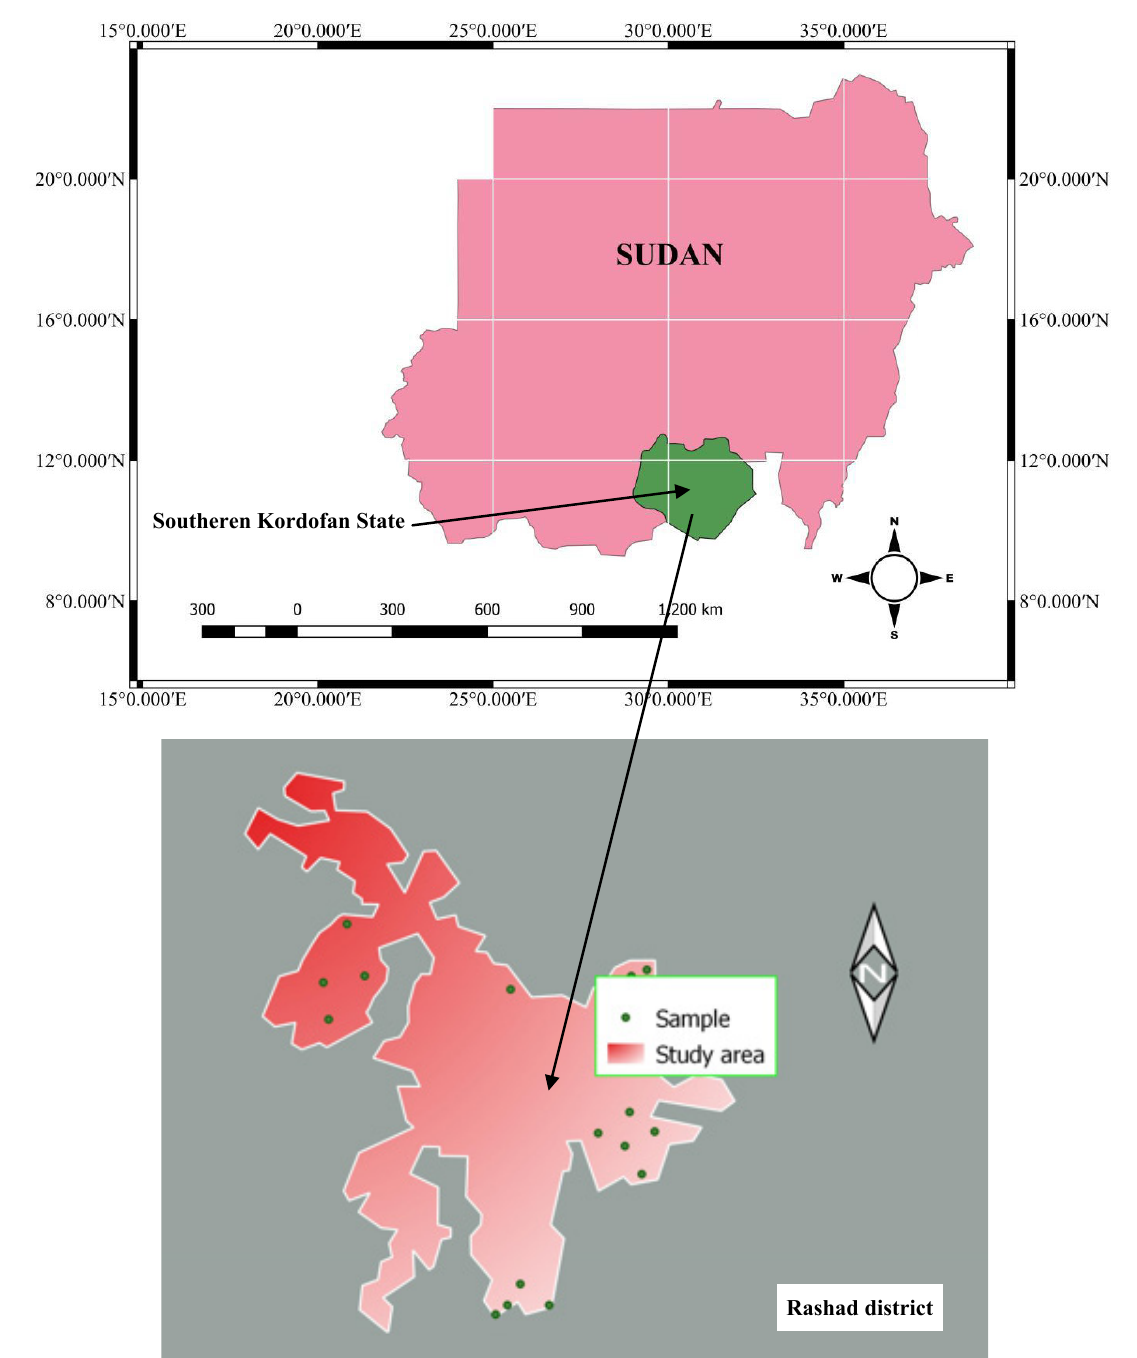
Fig 1. Map of the study area showing distribution of sampling